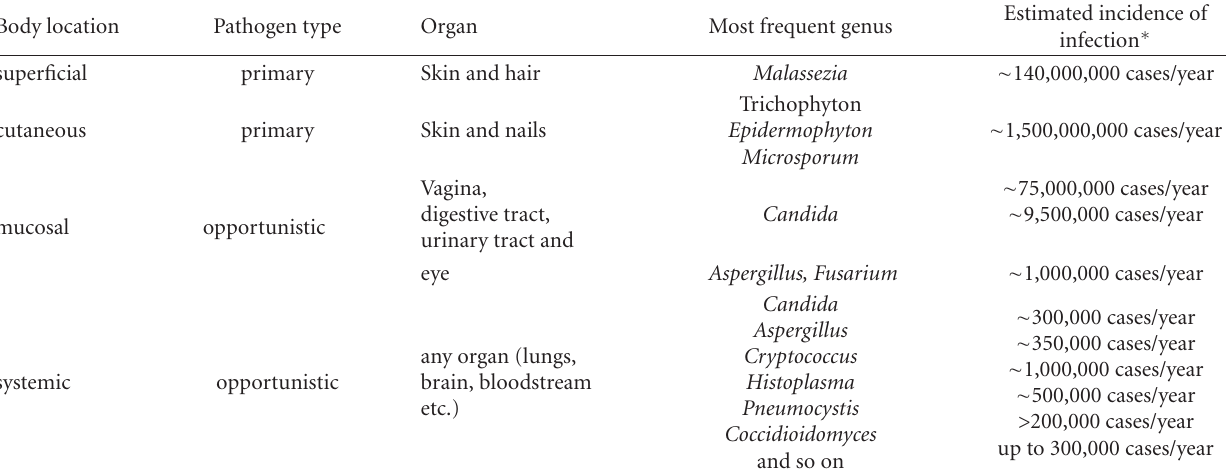
Table 1: Characteristics of main fungal infections